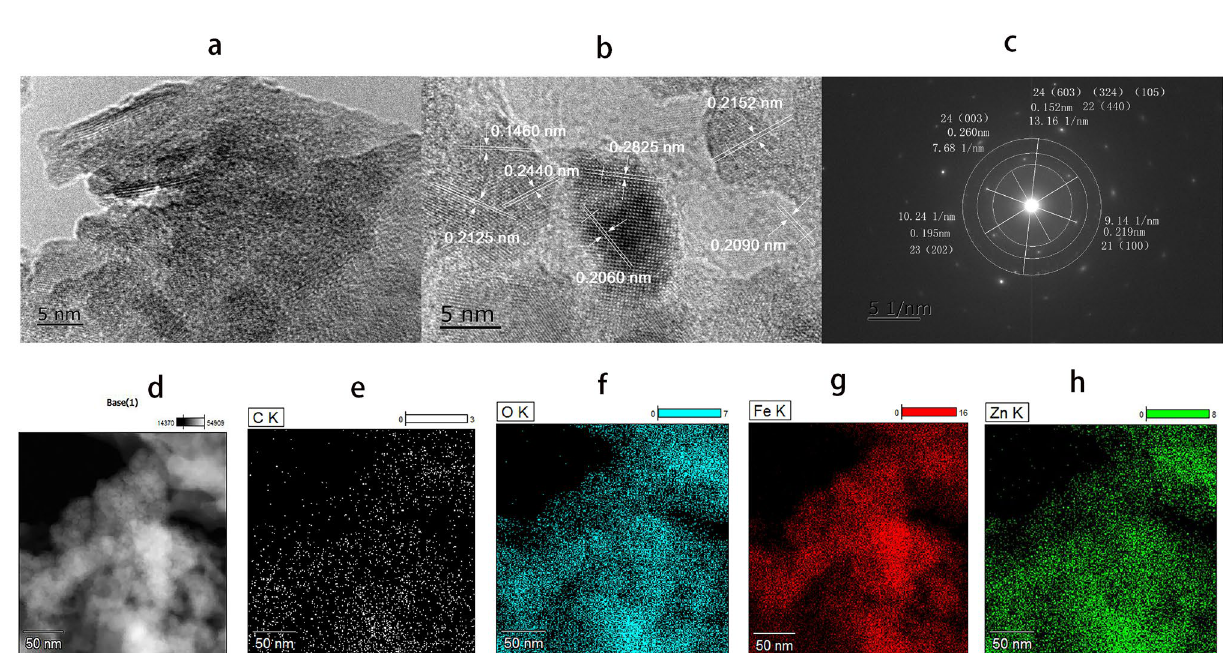
Figure 7. ( a–c ) HR-TEM images of rGO/NZV-FeZn with micrograph resolution of 5 and 2 nm and SAED pattern, ( d–h ) distribution maps of C, O, Fe, and Zn in